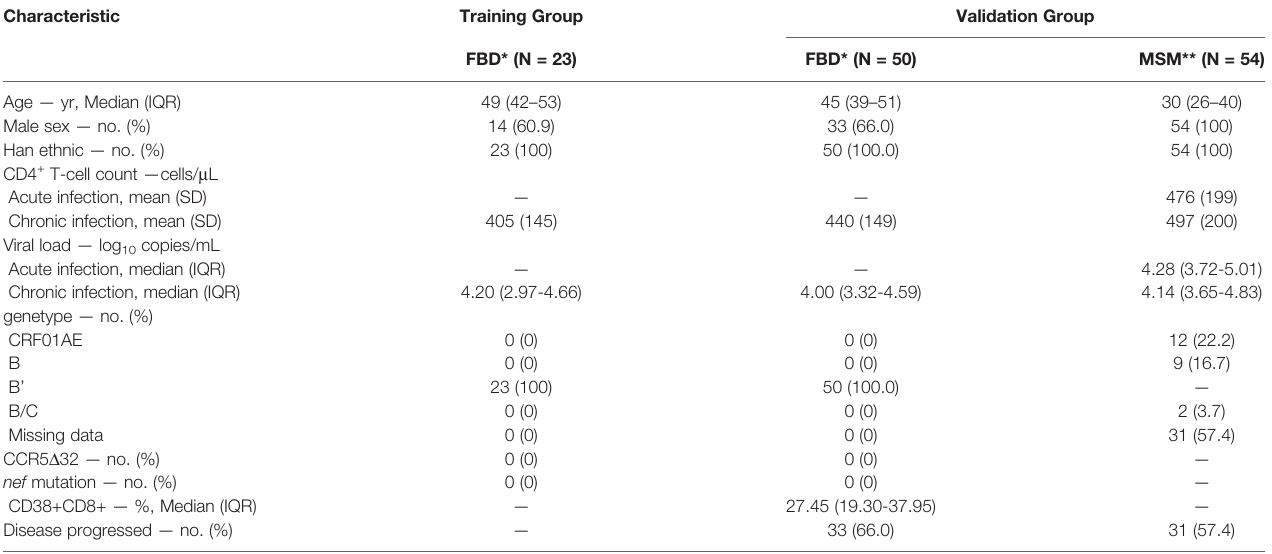
TABLE 1 | Characteristic of HIV-1 infected individuals participating in this study.